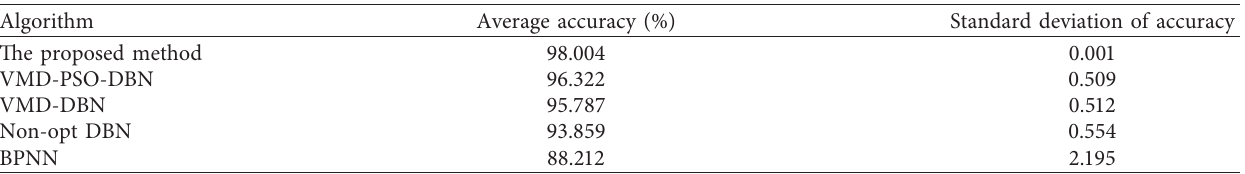
Figure 13: Diagnostic accuracy in 10 tests. Table 7: Monitoring and diagnosis results of 10